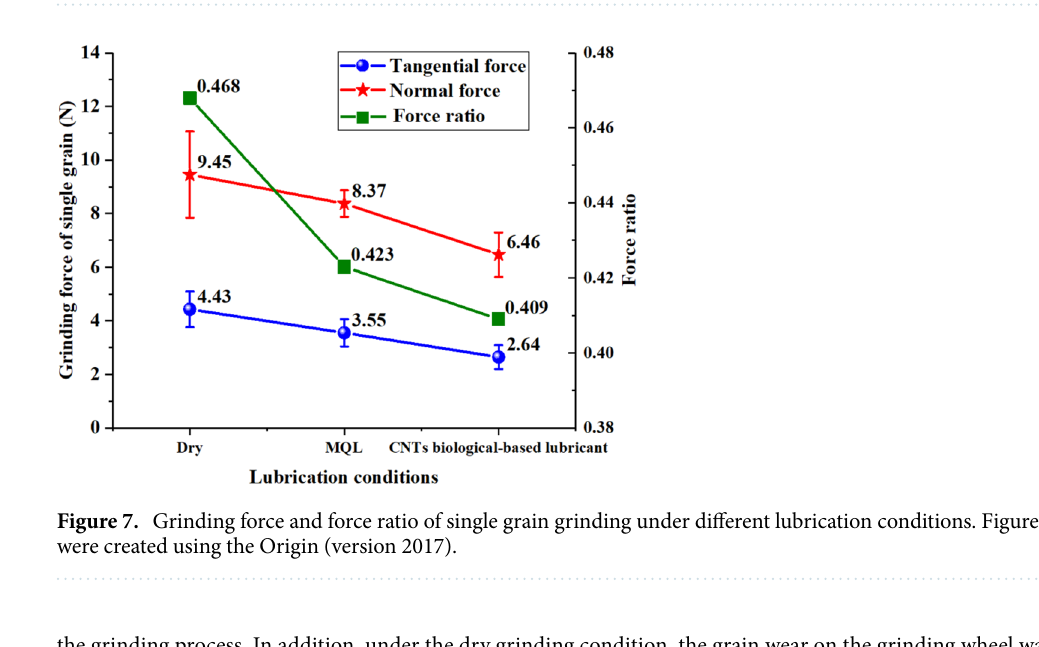
Figure 6. 3D morphology and surface roughness of grinding under different lubrication conditions. Figures were created using the Microsoft Visio sofware (version 2010) and Origin (version 2017).